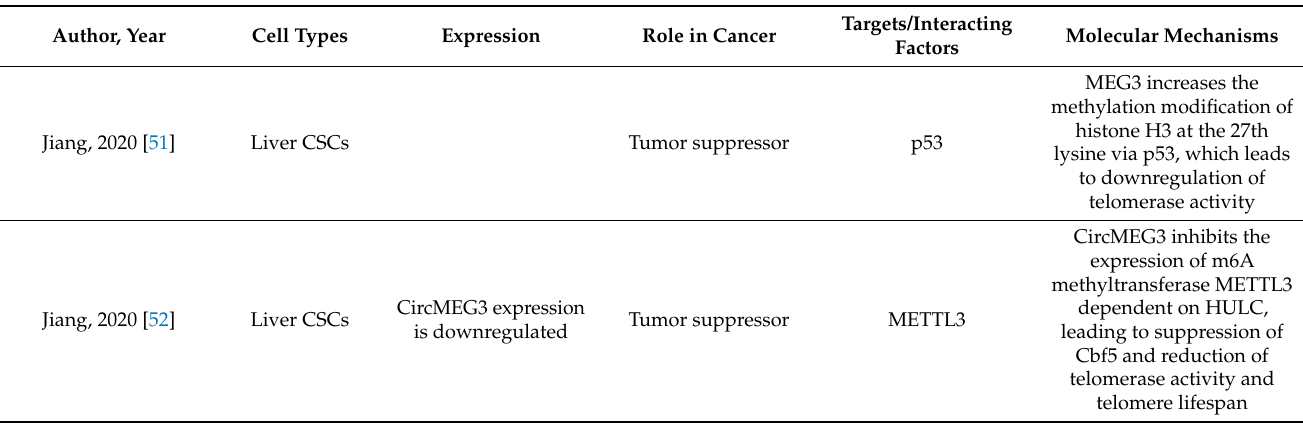
Table 2. The role of MEG3 in various types of cancer stem